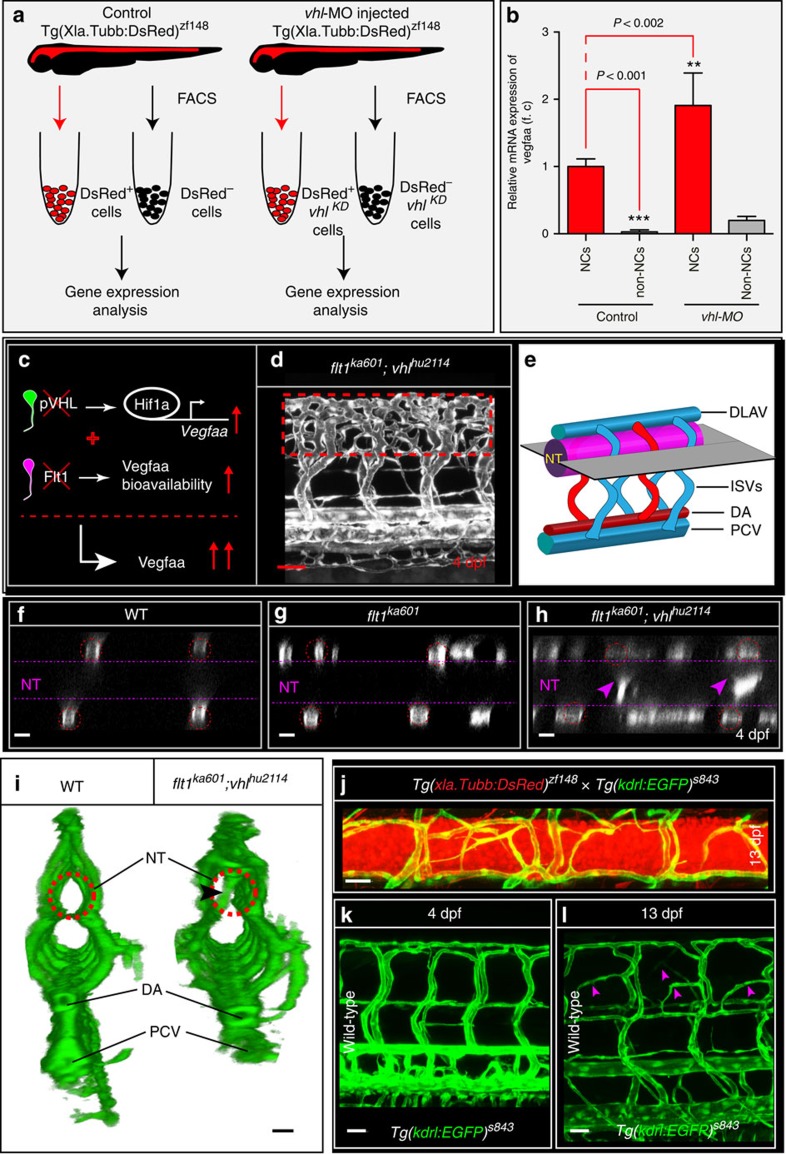
Neurons are a major source of Vegfaa and attract sprouting vessels.(a) FACS procedure for obtaining neuronal cells in control and vhl morphants using Tg(Xla.Tubb:DsRed)zf148 neuronal reporter embryos. (b) Quantification of vegfaa expression using real-time qPCR in FAC-sorted cell populations at 3 dpf. Note that neuronal cells expressed significantly more vegfaa than non-neuronal cells. Loss of vhl promoted neuronal vegfaa expression. Mean±s.e.m., n=3 separate experiments in triplicate (two-way ANOVA). (c) Schematic representation: loss of vhl augments vegfaa transcription, loss of flt1 augments Vegfaa bioavailability; combining both mutants augments Vegfaa bioavailability above single mutant level. (d) Trunk vasculature in flt1ka601;vhlhu2114 double mutants at 4 dpf. Note the severe hyper-branching at the level of the neural tube, red-dotted box. (e) Schematic representation of optical section (shown in f–h) through the neural tube and associated trunk vasculature. (f–h) Dorsal view on optical section through WT (f), flt1ka601 (g) and flt1ka601;vhlhu2114 double mutants (h). Note invasion of sprouts into the neural tube in double mutants (arrowheads in h). Red circle indicates position of ISVs, dotted line neural tube boundary. (i) Transverse 3D-rendered view of vasculature (green) through the trunk in WT (left panel) and flt1ka601;vhlhu2114 double mutants (right panel); note vessels penetrating the neural tube in mutant (compare vessel in dotted circle right panel, arrowhead; such vessels are absent in WT left panel; representative image from 3 separate experiments). (j) Representative image of spinal cord vascular network in Tg(xIa.Tubb:DsRed)zf148; Tg(kdrl:EGFP)s843 double transgenic at 13 dpf. (k,l) Comparison of trunk vasculature in WT at 4 dpf (k) and at 13 dpf (l); note the emergence of ectopic branches (pink arrowheads) at level of the spinal cord. DA, dorsal aorta; f.c. fold change; KD, knockdown; NT, neural tube; NC, neuronal cell; PCV, posterior cardinal vein. Mutants are in Tg(kdrl:EGFP)s843 background. Scale bar, 50 μm in d; 25 μm in f–l.